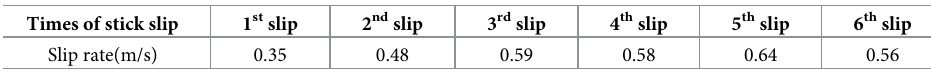
Table 2. Increase in slip rate in the initial stage of the stick-slip. Times of stick slip